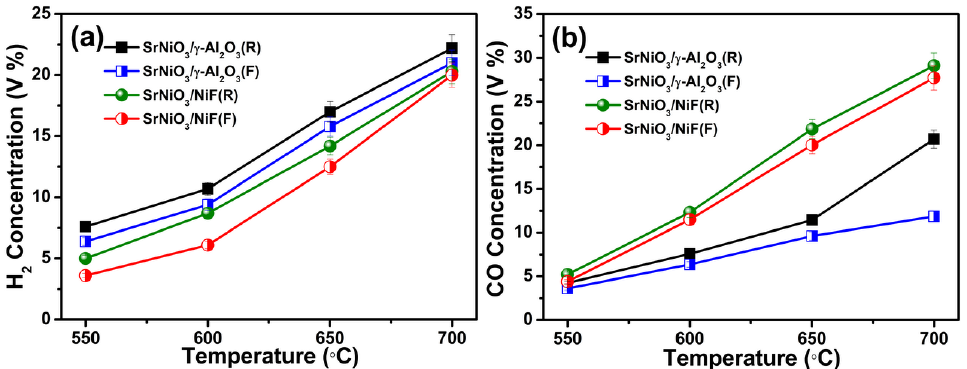
Figure 8. The product of DRP as a function of temperature over SrNiO 3 /γ-Al 2 O 3 (F and R) and SrNiO 3 /NiF (F and R) catalysts at 550 °C to 700 °C under atmospheric pressure in CPR = 3 (30:10:60 CO 2 :C 3 H 8 :Ar) and total flow rate = 200 mL/min ( a ) H 2 concentration (vol.%) and ( b ) CO concentration (vol.%).